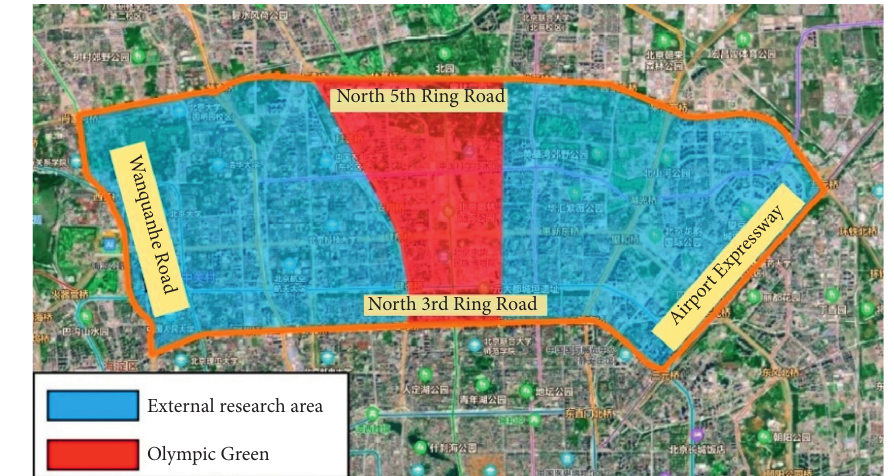
Figure 3: Research